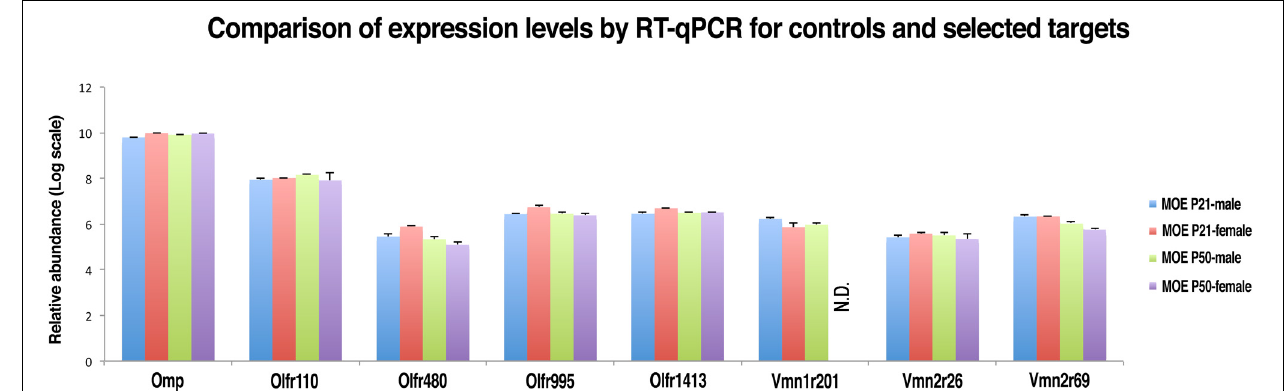
FIGURE 6 | Validation of nanoCAGE data by qRT-PCR confirms that the expression levels of selected VRs in the MOE of young and adult mice are comparable to the expression levels of ORs genes with similar tag counts in nanoCAGE libraries. The qRT-PCR validation was performed in triplicates on RNA purified from the dissected MOE and VNO of P21 (males